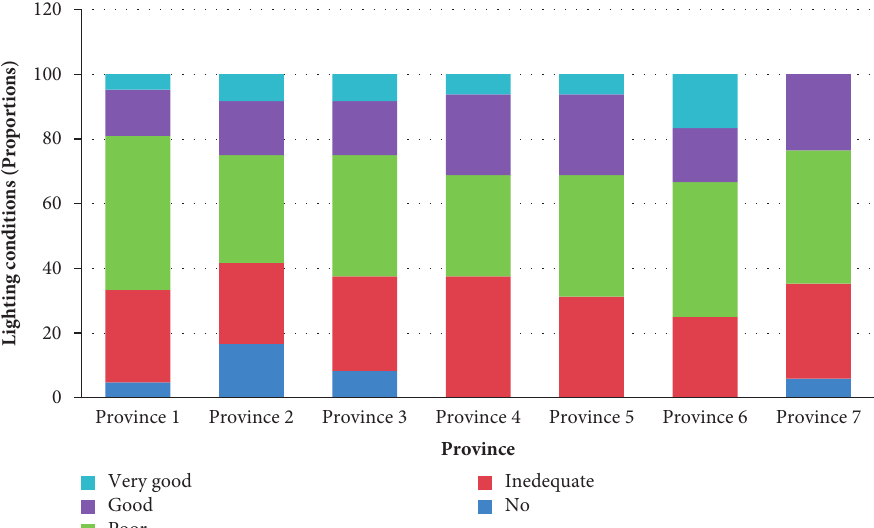
Figure 4: Provincewise lighting conditions in classrooms.